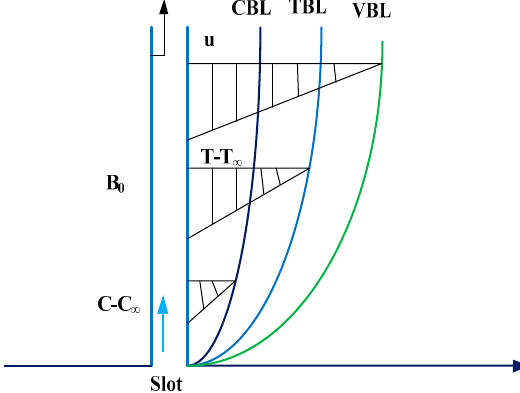
Figure 1. The schematic diagram of the Maxwell nanofluid flow.